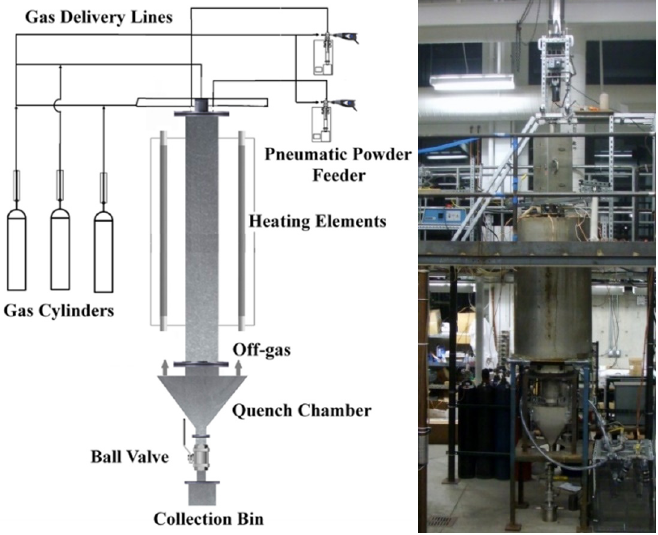
Figure 2. The Utah laboratory flash ironmaking reactor (I.D. 0.19 m and length 2.13 m).